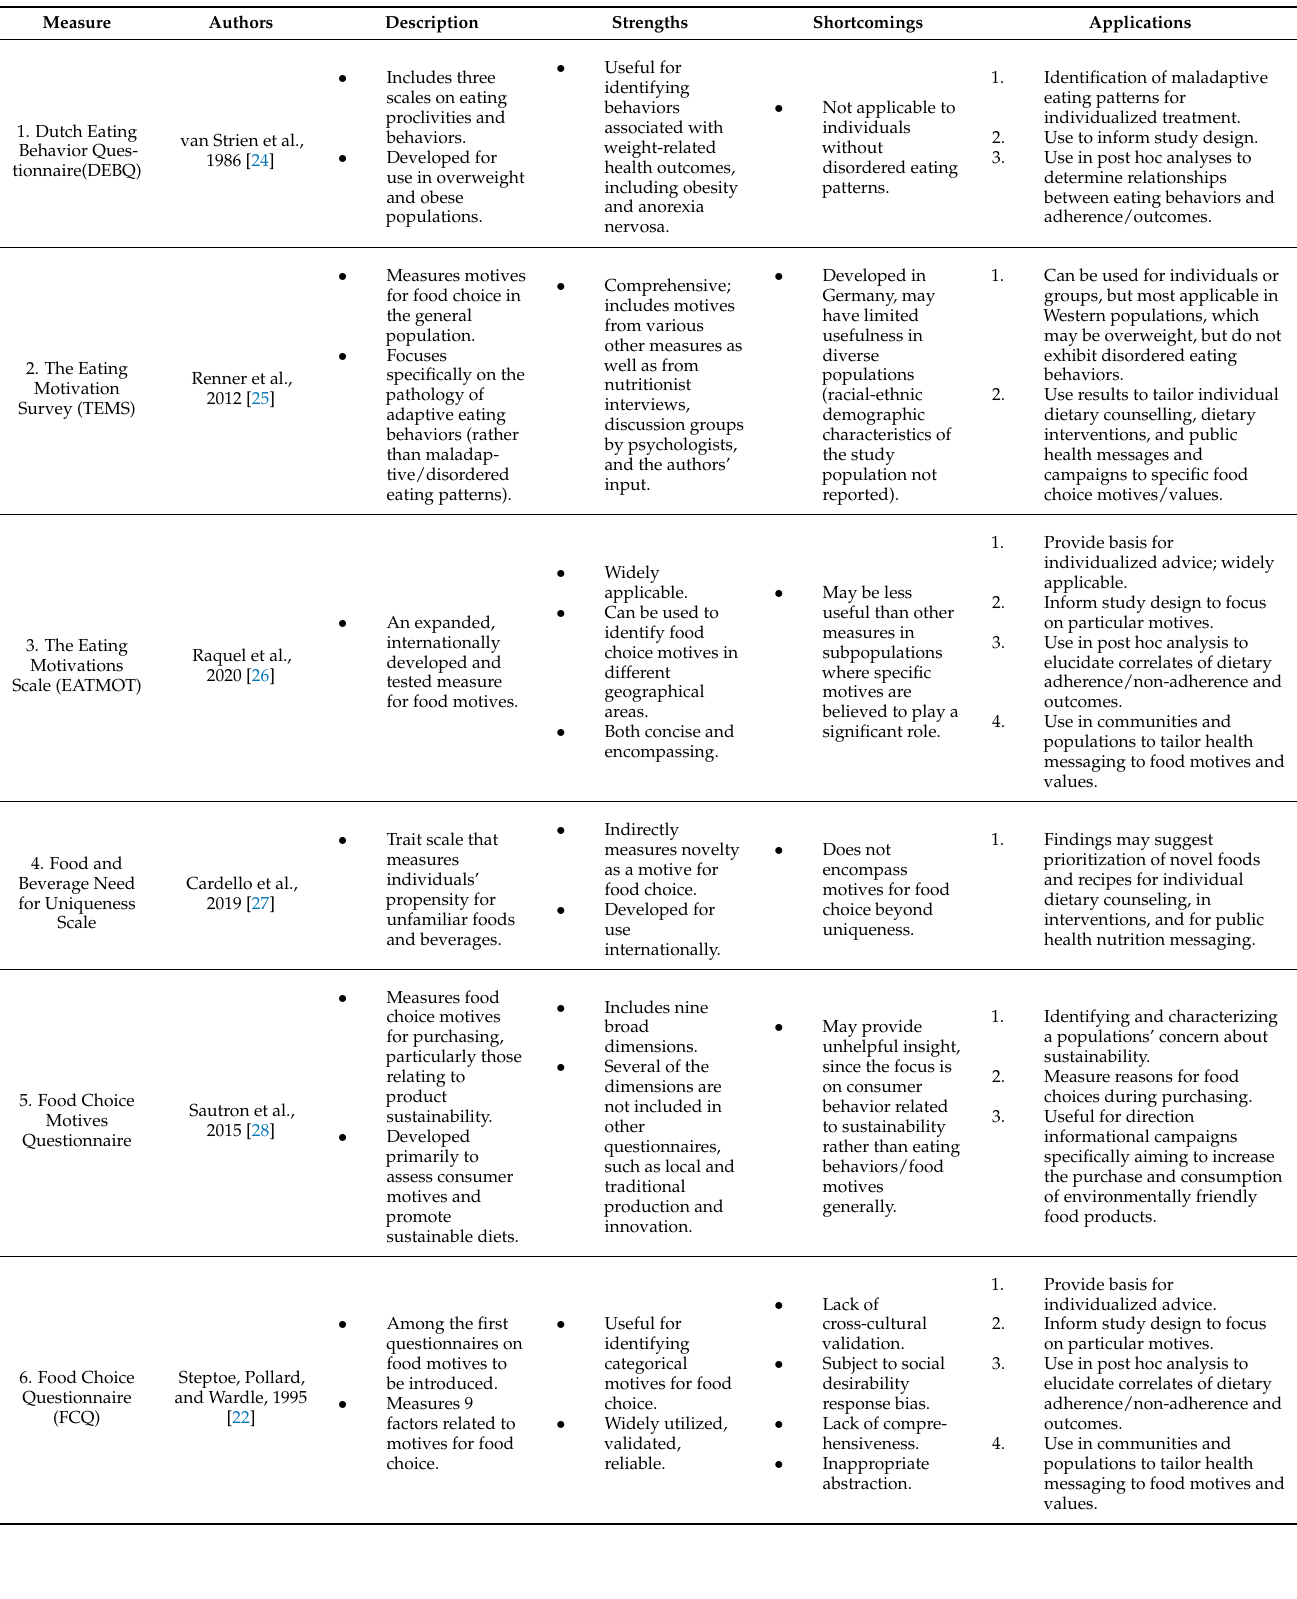
Table 1. Measures of food motives and